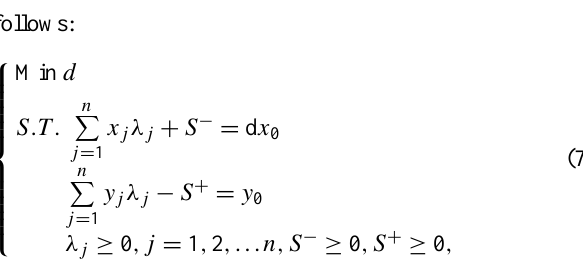
Fig.8. Spatial and temporal DMUS determination Fig. 8. Spatial and temporal DMUs